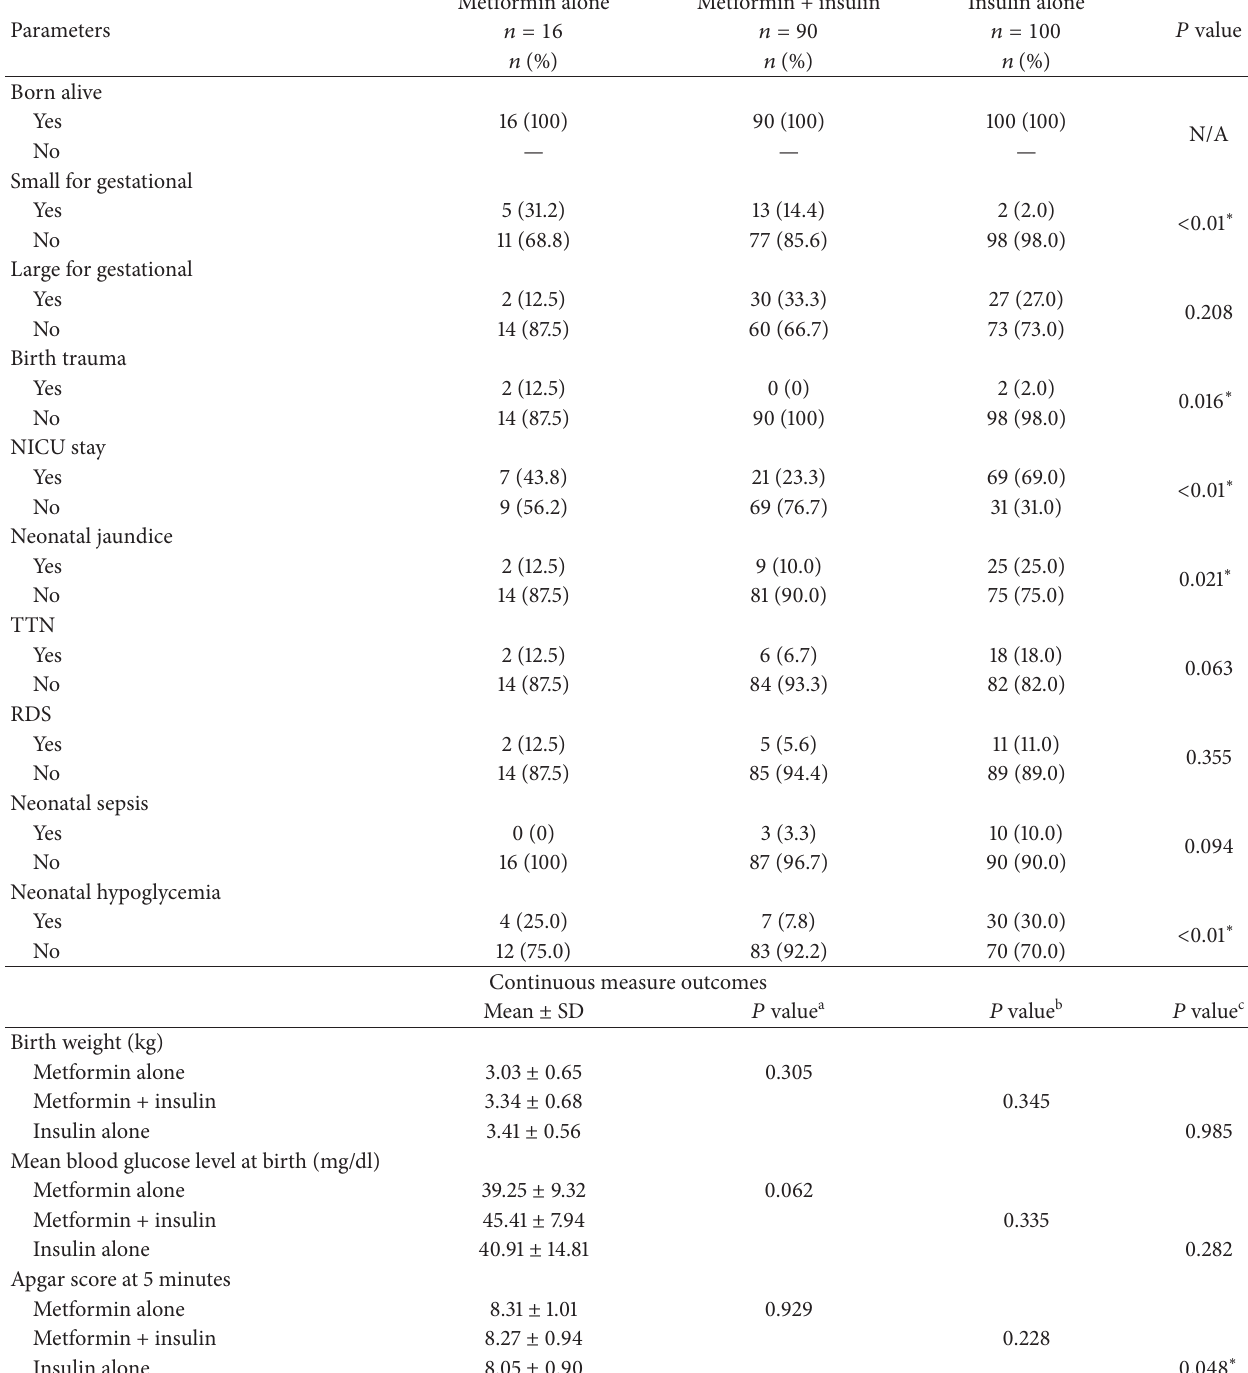
Table 3: Neonatal outcomes in treatment groups ( 𝑛 = 206